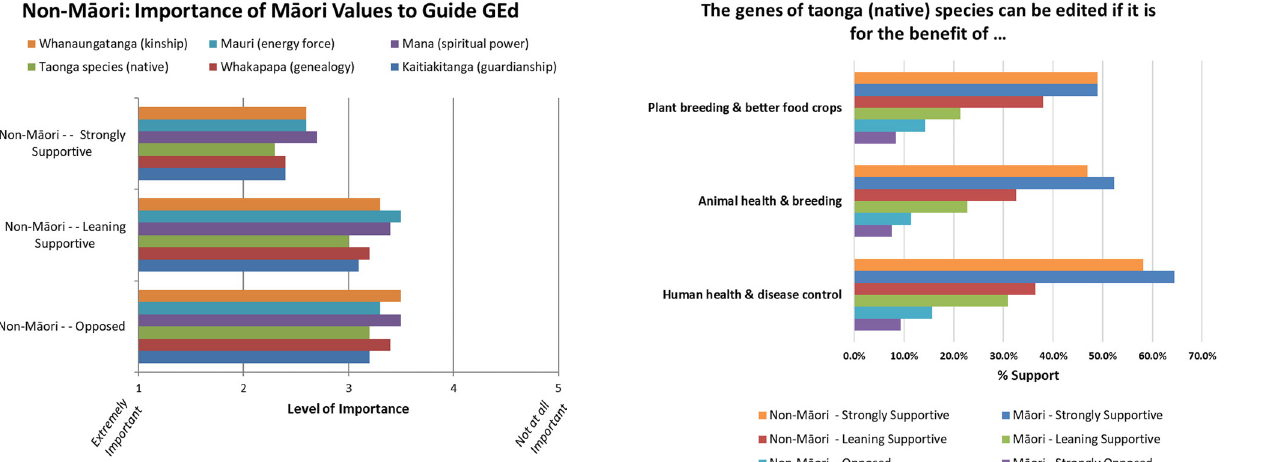
Fig. 8 Level of support by clusters for the conditions under which taonga species can be edited. The Strongly Supportive clusters (both M ā ori and non-M ā ori) have the highest percentage across the clusters that support gene editing of taonga (native)species, although the support differs based on its application. The Opposed clusters have the lowest percentage who support editing taonga species, with the Leaning Supportive falling between the other two clusters in their support. Importantly, except for gene editing of “ human health & disease control ” the level of support for editing native species in other applications is below 50% in all six of the clusters. Non- M ā ori Strongly Supportive are shown in orange, M ā ori Strongly Supportive dark blue, non-M ā ori Leaning Supportive red,M ā ori Leaning Supportive green, non-M ā ori Opposed light blue, and M ā ori Strongly Opposed purple.